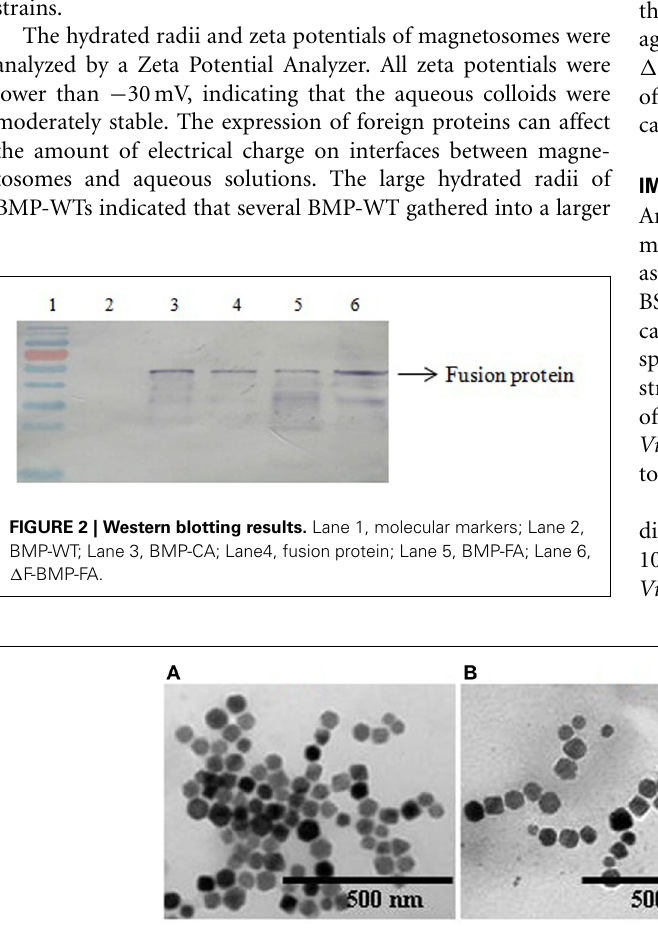
FIGURE 3 | Electron micrographs of magnetosomes from various strains. (A) , BMP-WT; (B) , BMP-FA; (C) , (cid:2) F-BMP-FA.